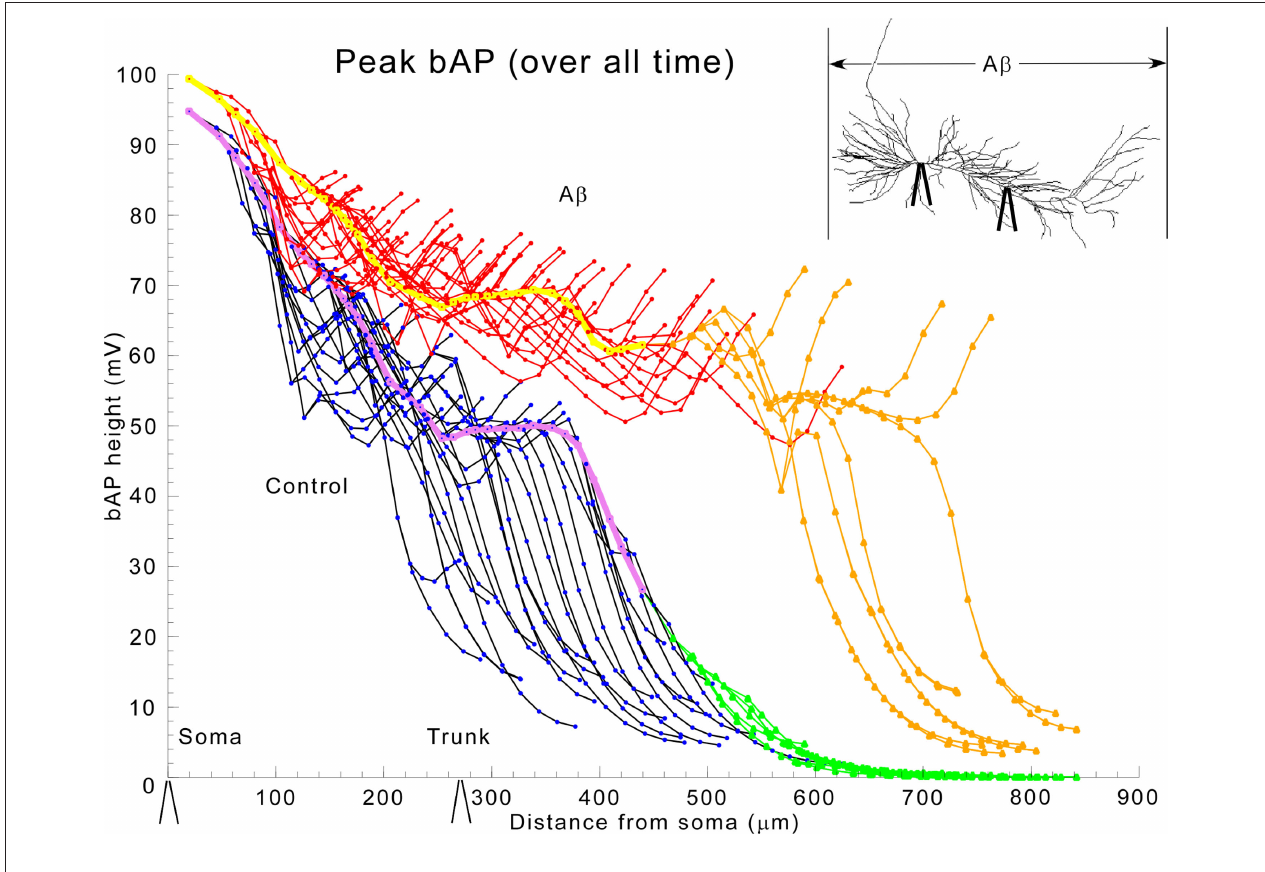
Figure 2 | global application of a β enhances bAP invasion in the trunk, obliques, and tuft. bAP amplitudes in apical dendritic compartments of the model as a function of distance from the soma. Color key: normal conditions (black-oblique dendrites, purple-trunk, green-apical tuft), and in the presence of 1 μM a β (red-oblique dendrites, yellow-trunk, tan-apical tuft).